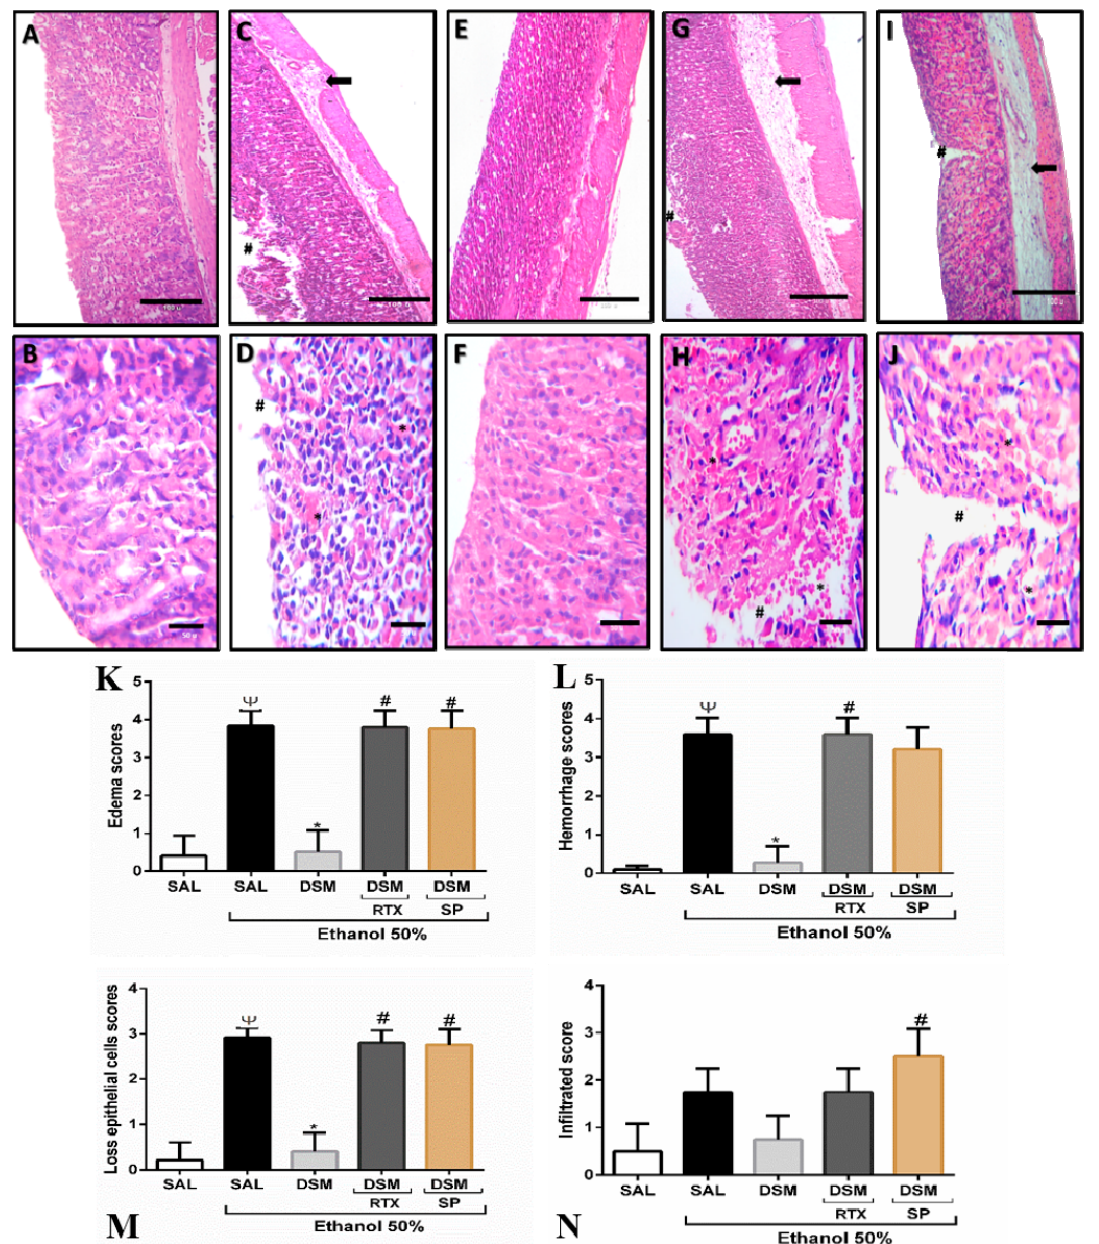
Figure 2. Histopathological analysis of gastric mucosa. ( A – J ) Photomicrographs: 100 × magnification for the first line, and 400 × for the second line. ( A , B ): Healthy group. ( C , D ): Injured group (50% ethanol). ( E , F ): DSM supplementation (10 8 CFU/g • bw/day for 3 days) and ethanol administration. ( G , H ): Pretreatment with DSM (3 days) and treatment with RTX and 50% ethanol. ( I , J ): DSM supplementation and treatment with 1 µ mol/L per 20 g i.p. of SP and 50% ethanol. Arrows: Edema; Tags: Epithelial cell loss; Asterisk: Hemorrhage. ( K – N ): Quantitative analysis of microscopic scores of the gastric mucosa upon ethanol-induced damage (hemorrhage, edema, epithelial cell loss, and infiltration). Results are expressed as mean ± S.E.M. (5–6 mice per group), and analyzed using Kruskal–Wallis nonparametric tests, followed by Dunn’s test. Ψ p < 0.05 versus healthy group; * p < 0.05 versus injured group; # p < 0.05 versus the DSM-supplemented group.